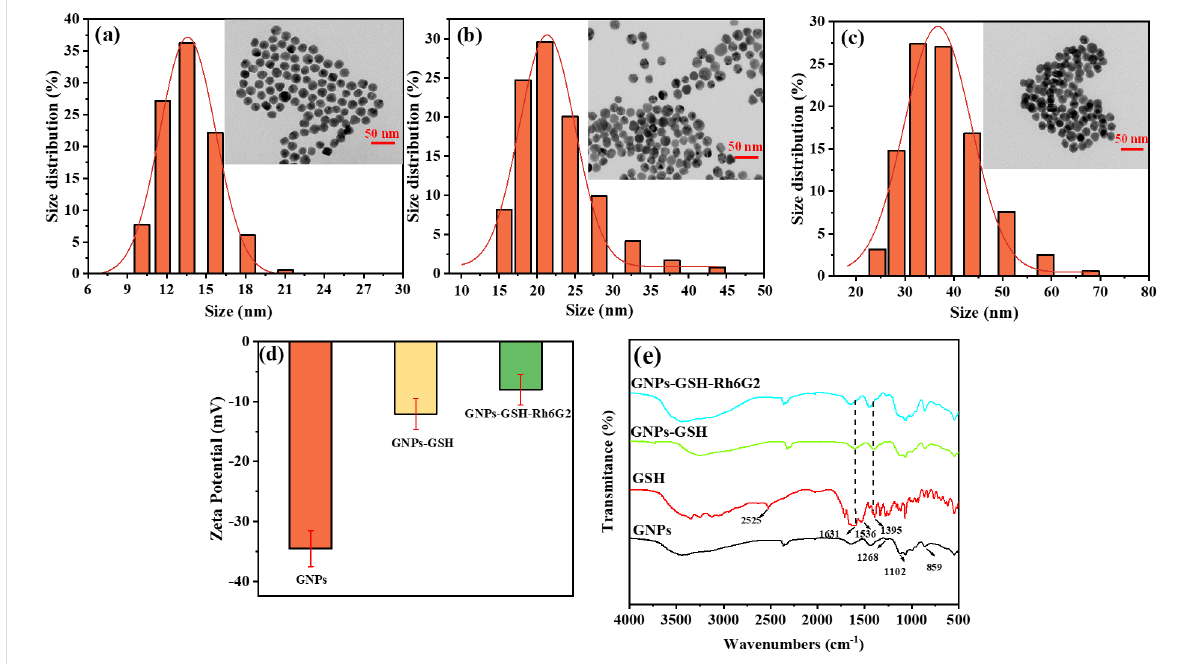
Figure 2: DLS of (a) GNPs, (b) GNPs-GSH, and (c) GNPs-GSH-Rh6G2 (insets: TEM images); (d) zeta potential of GNPs, GNPs-GSH, and GNPs- GSH-Rh6G2; (e) FTIR spectra of GNPs, GSH, GNPs-GSH, and GNPs-GSH-Rh6G2.